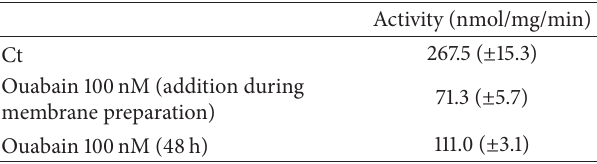
Table 2: Na,K-ATPase